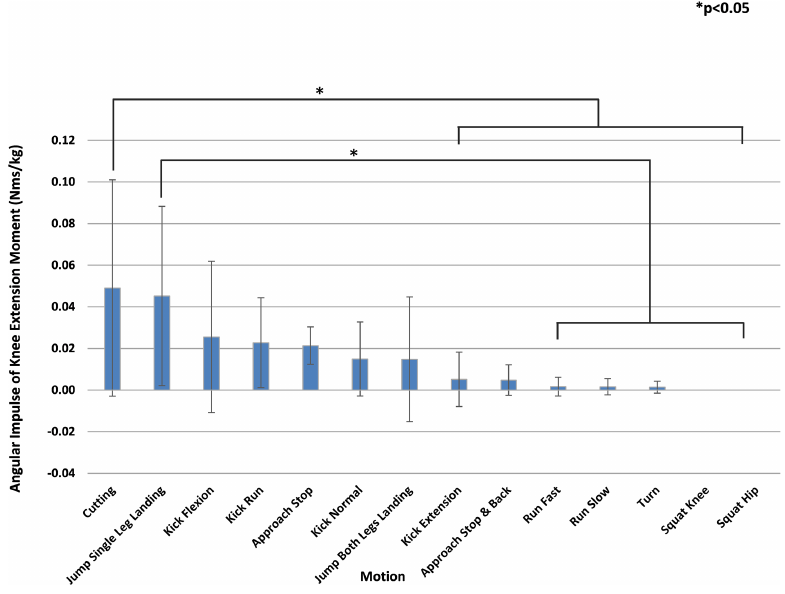
Fig 5. Motion comparison by averageangular impulse of the knee extension moment (2.5 Nm/kg or greater). Mean values are shown in descendingorder from left to right. The angular impulseof "Cutting"was significantly greater than 7 types of motion. Multiple comparisons were performed after ANOVA to show statistically significantdifferences betweenmotions. * P < 0.05.